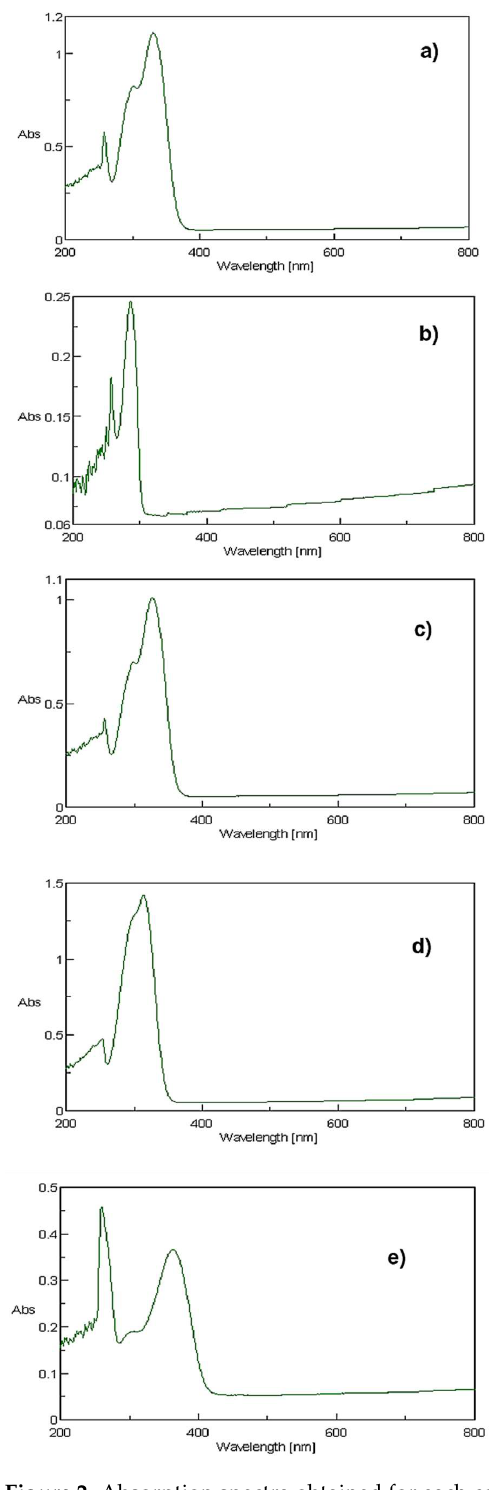
Figure 2. Absorption spectra obtained for each compound dissolved in DMSO at a concentration of 10 µg/mL. ( a ) Caffeic acid; ( b ) DOPAC; ( c ) ferulic acid; ( d ) p -coumaric acid, and ( e ) rutin. The ROS assay was carried out for the polyphenolic compounds, and the capacity of the tested substances to generate ROS, at the concentration of 200 µ M, is shown in Table